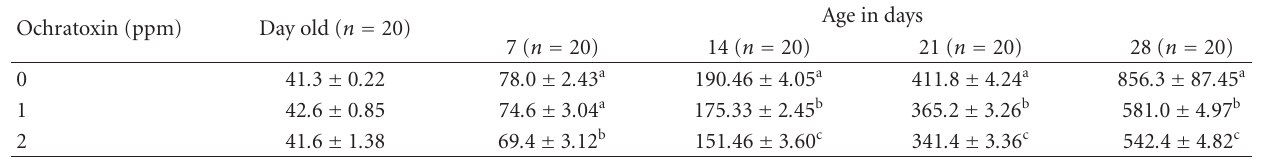
Table 1: Mean ( ± SE) weekly body weight (g) of broiler chickens fed ochratoxin. Ochratoxin (ppm)